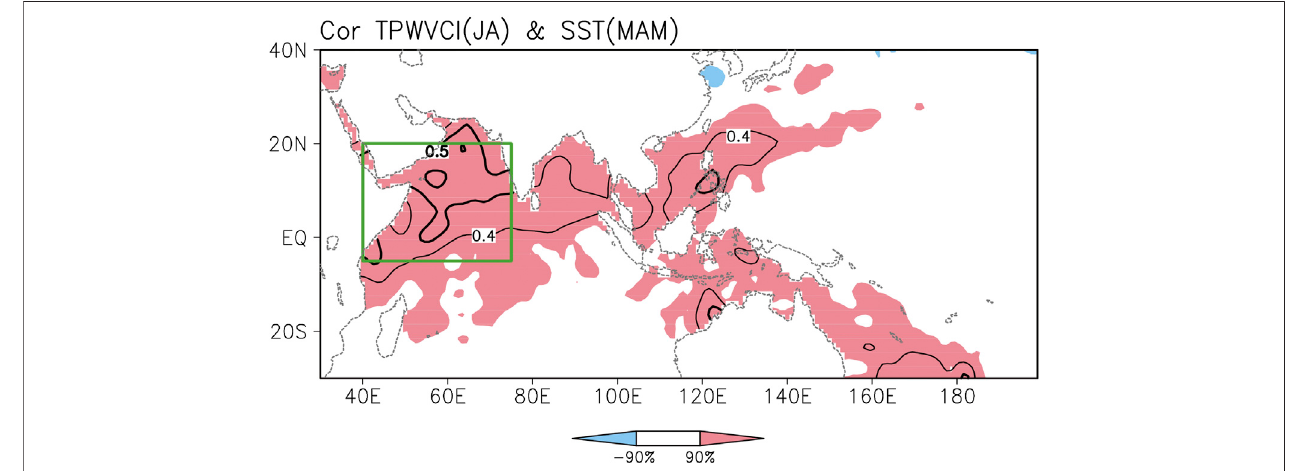
FIGURE2 | Distributions ofthe correlation coef fi cients between TPWVCIand the springSST inIndo-Paci fi cOcean (contours indicate values > (cid:2) 0.4). Shaded areas indicate correlations that have passed the test at 90% con fi dence level. SST averaged over the green box is calculated for WTIO SSTI.